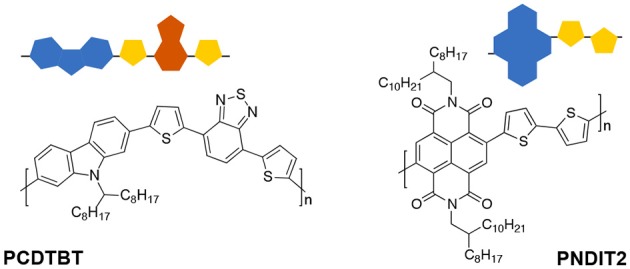
Chemical structures of the two polymers investigated, together with the symbols used in the following. PCDTBT is a p-type polymer known for its rather high efficiency combined with long-term stability. PNDIT2 is a n-type polymer with remarkable charge carrier mobilities.